Question: Produce a descriptive caption suitable for publication.
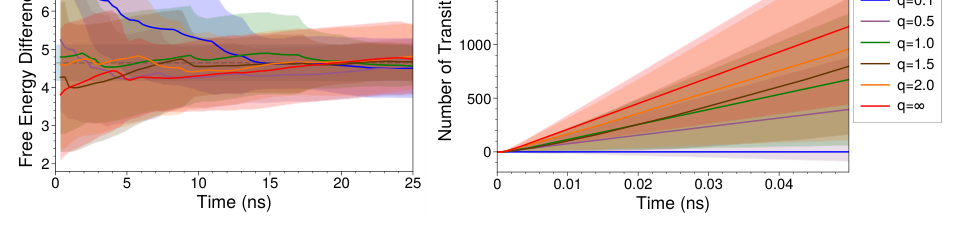
Answer: Behavior of the Vendi scores for sampling Alanine Dipeptide. Left: Convergence of Vendi sampling under different scores over 25ns of simulation to the free energy difference estimated from long unbiased simulations (dashed gray line). Right: Number of transitions for each score in and out of the left-handed state over the course of the first 50ps of simulation. Shaded regions represent uncertainty over 10 trials.